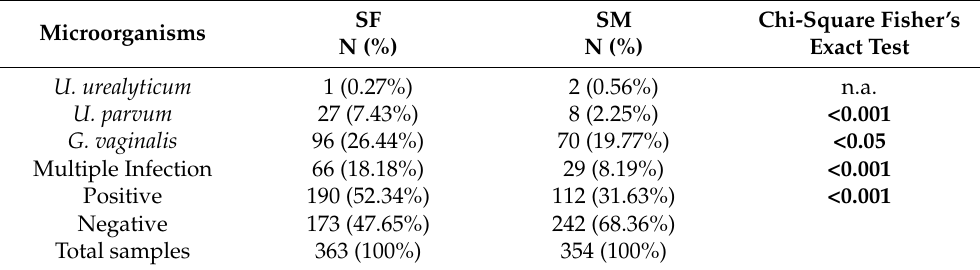
Table 3. Prevalence of GIs detected in female and male genital specimens.